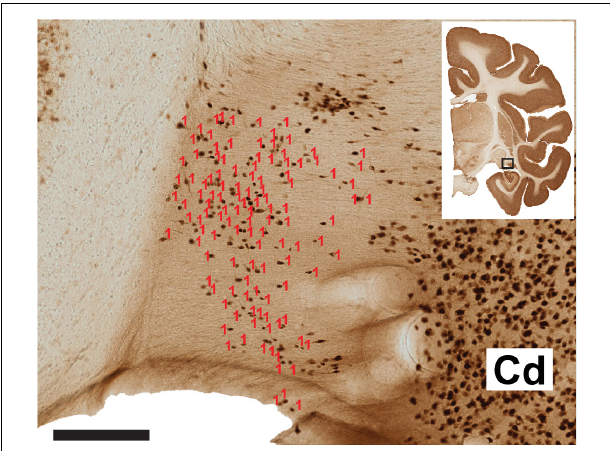
FIGURE 1 | Representative section of the ventral ST and laterally adjoining caudate nucleus (Cd). The number of neurons (visualized by NeuN) has been scored in Image J software (red counters). A dorsal cell cluster was not counted, as this was considered ambiguous or comprised of neurons from the Cd, as judged by reference to an adjoining ChAT reacted section (not shown). The coronal section micrograph at upper right indicates the AP coronal level, with the hollow box highlighting the vST and the adjoining caudate nucleus. Scale bar = 200 µ m. From B63 NeuN section 38.